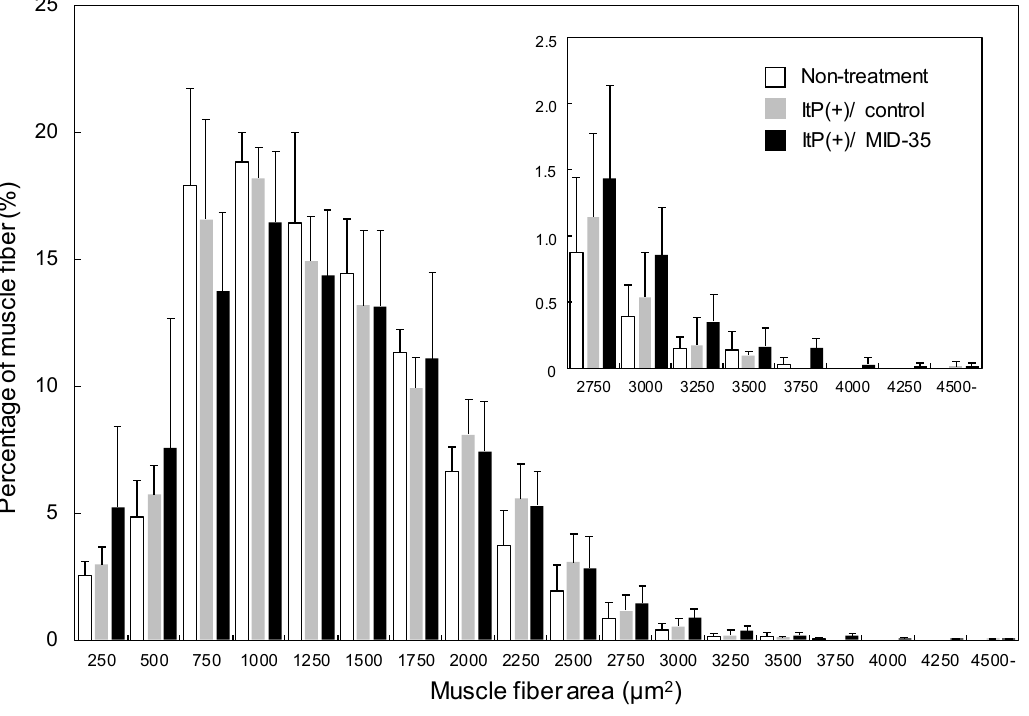
Figure 5. Analysis of the distribution of muscle fiber cross-sectional areas after delivery of MID-35 by ItP: The percentages of muscle fiber having the noted sizes from the analysis in Figure 4 were calculated. The columns of white, gray and black are the cross-sectional areas of muscle collected from non-treated mice (Non-treatment), control ItP/PBS-treated mice (ItP(+)/control) and ItP/MID- 35-treated mice (ItP(+)/MID-35), respectively. The values are shown as means ± SD obtained from five different images of muscle